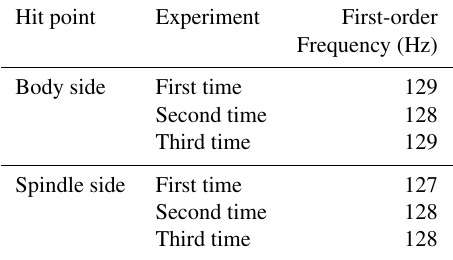
Table 2. Modal test results.